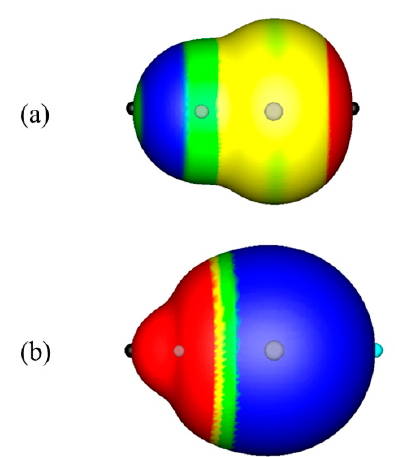
Figure 1. Computed electrostatic potentials on the 0.001 au surfaces of ( a ) FCl and ( b ) LiCl. The gray circles indicate the positions of the atoms; the chlorines are on the right in both molecules. Color ranges, in kcal / mole: Red, more positive than 10; yellow, between 10 and zero; green, between zero and − 10; blue, more negative than − 10. The black hemispheres correspond to V S,max on both atoms in FCl and the lithium in LiCl; the blue hemisphere corresponds to a V S,min on the chlorine in LiCl. The V S,max on the fluorine in FCl is negative. Note that the outer surface of the chlorine in FCl is slightly flattened compared to that in LiCl; this is due to the σ -hole of the chlorine in FCl. In LiCl, on the other hand, the chlorine has a minimum on the extension of the LiCl bond, with V S,min = − 43.1 kcal/mol. The distance from the chlorine nucleus to the 0.001 au surface along the bond extension is 2.15 Å, and it is 2.05 Å perpendicular to the bond. This indicates an increase in electronic density on the outer side of the chlorine; there is no σ -hole on the chlorine. It can be seen in Figure 1